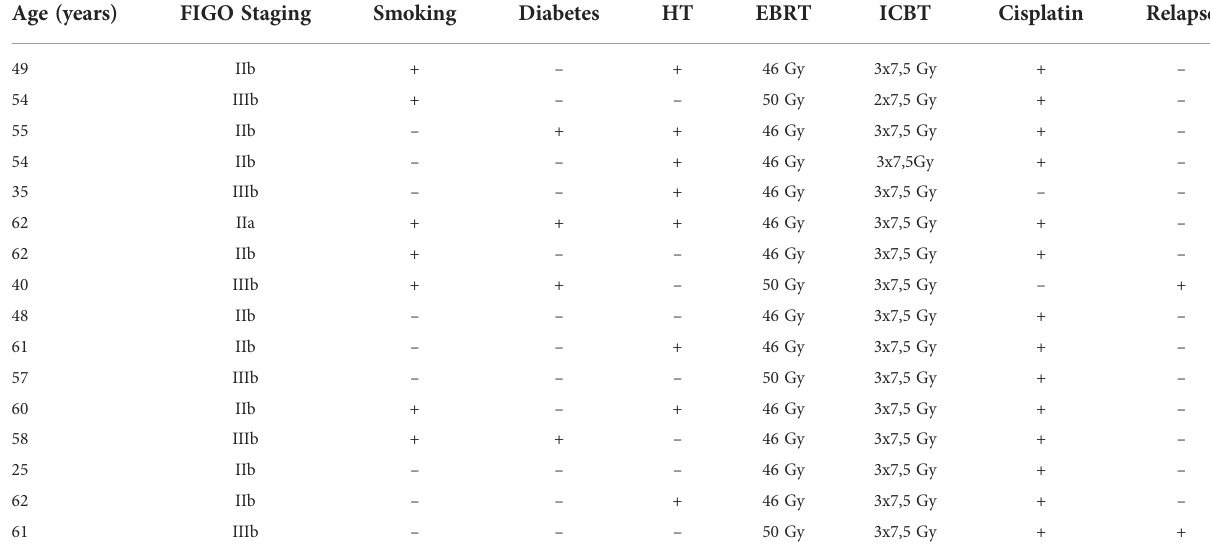
FIGO, International Federation of Gynecology and Obstetrics; HT, Hypertension; EBRT, radiation therapy; ICBT, brachytherapy. +, positive; -,